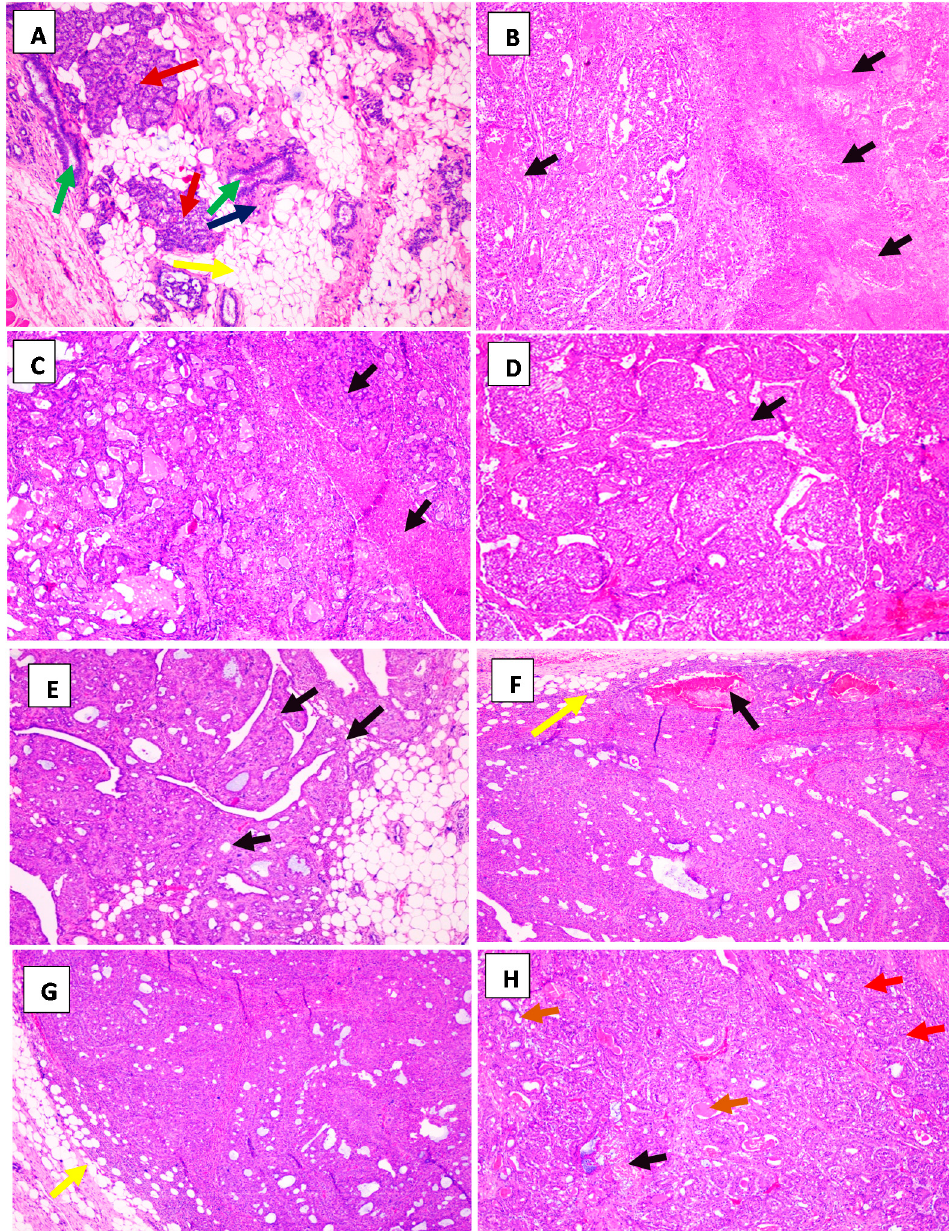
Figure 5. Histopathological profiles (H&E, × 400) of representative mammary tumor tissues from various experimental rat groups (n = 6). ( A ) The normal breast tissue of the control group: mammary acini (red narrows), conduit excretory (green narrows), breast stroma (blue narrow), adipose tissue (yellow narrow). ( B ) DMBA group; infiltrating carcinoma with extensive tumor necrosis (black narrow). ( C ) EOCc-50 mg/kg/day + DMBA; solid-cribriform carcinoma, infiltrating, with necrosis areas (black narrows). ( D ) EOCc-100 mg/kg/day + DMBA, solid infiltrating carcinoma with necrosis area (black narrow). ( E ) EOCc-200 mg/kg/day + DMBA; solid carcinoma with “papillary” areas and infiltrating adipose tissue (black narrows). ( F ) Carvacrol-100 mg/kg/day + DMBA; solid infiltrating carcinoma, necrosis tumor necrosis (black narrow) and infiltrating adipose tissue (yellow narrows). ( G ) Carvacrol-200 mg/kg/day + DMBA; solid carcinoma infiltrating adipose tissue (yellow narrows). ( H ) EOCc 100 + carvacrol 100 mg/kg/day + DMBA; solid carcinoma (red narrows), necrosis (black narrow), tubular areas (brown narrows).